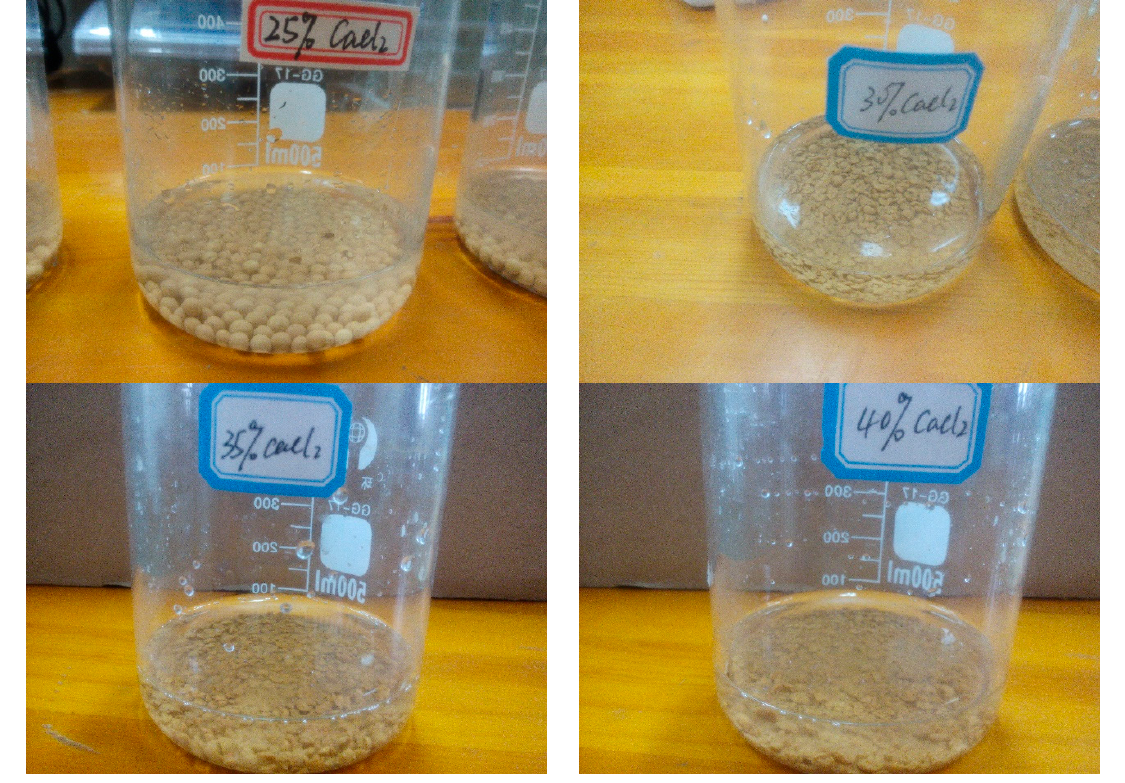
Figure 1. 13X/CaCl 2 composite adsorbent.